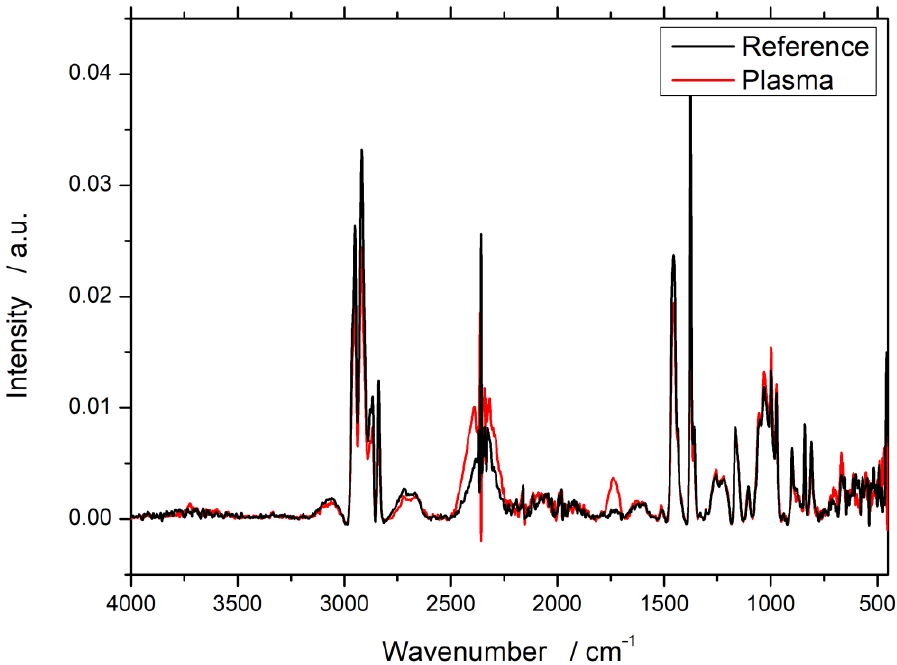
Figure A1. FTIR spectra of WPC with 60% wood content in PP before and after plasma treatment with 90% argon and 10% nitrogen as working gas.